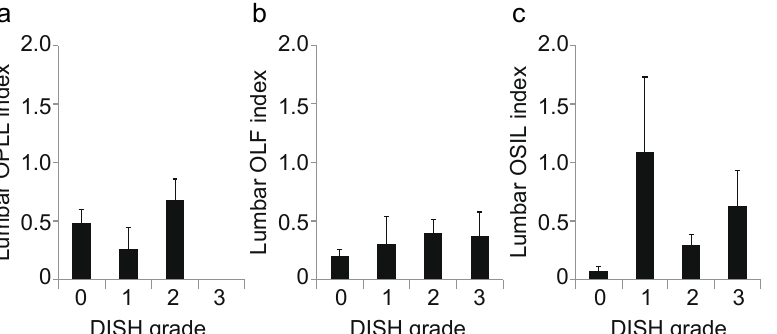
Figure 5. Correlation between DISH grade and OSL at the lumbar level. ( a ) Lumbar OPLL index; ( b ) lumbar OLF index; ( c ) lumbar OSIL index. DISH, diffuse idiopathic skeletal hyperostosis; OLF, ossification of the ligamentum flavum; OPLL, ossification of the posterior longitudinal ligament; OSIL, ossification of the supra/interspinous ligaments; OSL, ossification of the spinal ligaments.